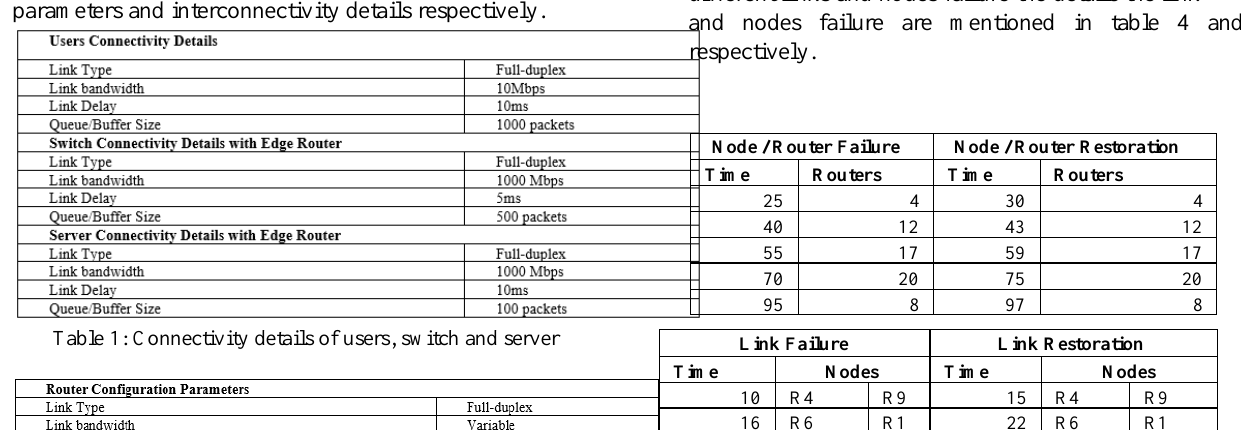
Table 2 and 3 explain the routers configuration parameters and interconnectivity details respectively.